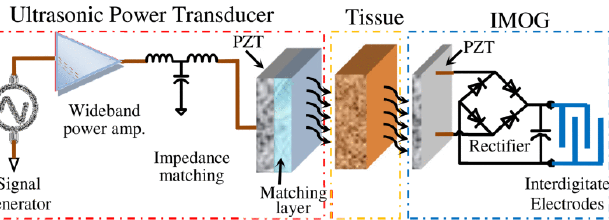
Figure 9. Block diagram of the system proposed in [34]. Reproduced with permission from T.